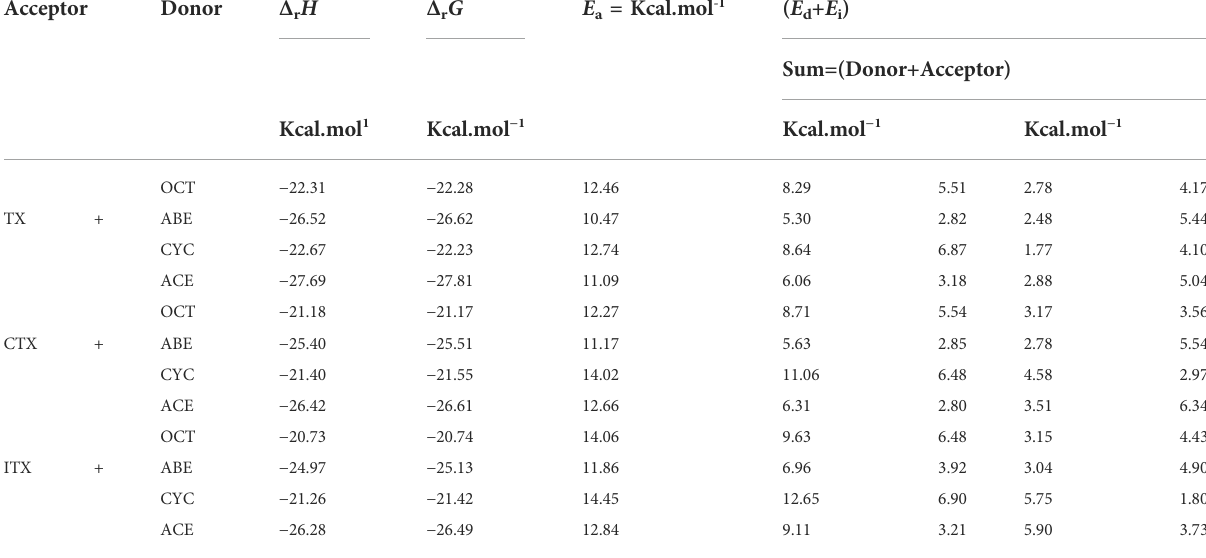
TABLE 2 Thermodynamic parameters of twelve hydrogen abstraction reactions.